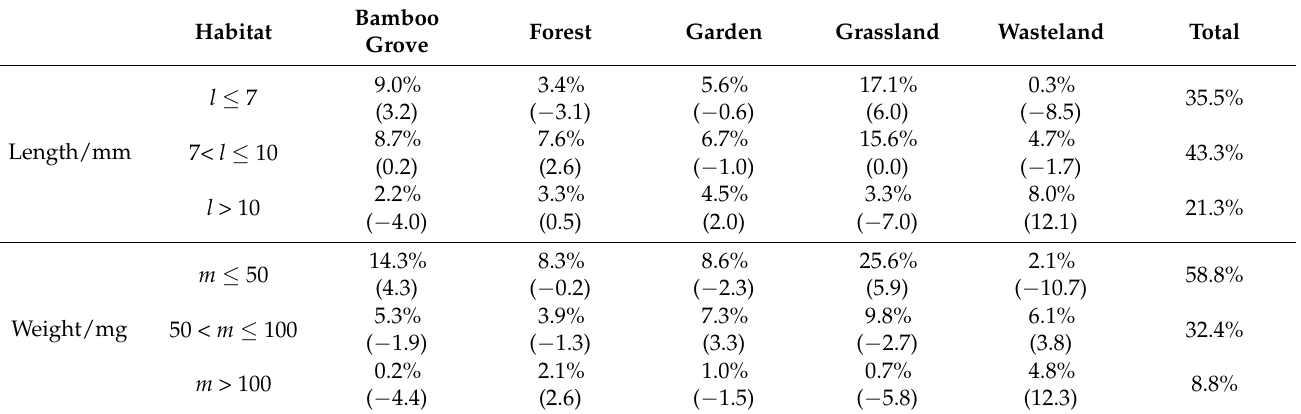
Table 3. The proportion and the residuals (in parentheses) of grouping composition by body length and body weight among different habitats.